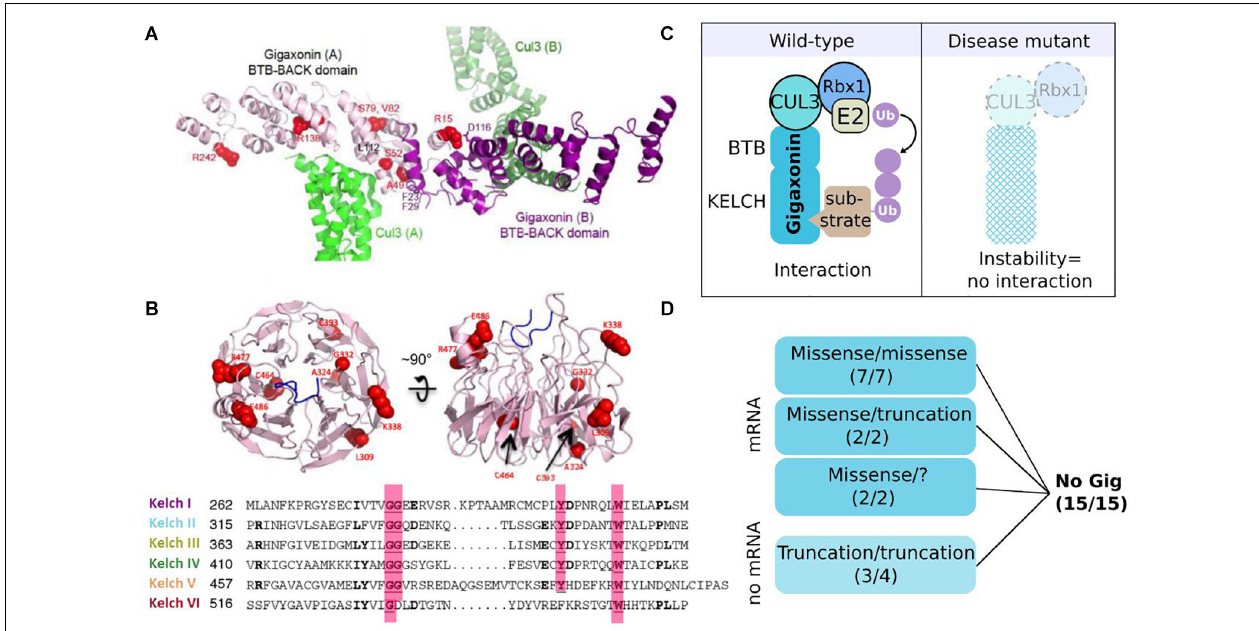
FIGURE 5 | Gigaxonin-E3 ligase: protein structure and instability as a general effect of mutations. (A) Structural model of the BTB-BACK homodimer of Gigaxonin (purple), in complex with Cul3 (green). Some mutations are represented in red (Boizot et al., 2014). (B) Representation of the top and side views of a structural model for the β -propeller Kelch domain of Gigaxonin, whose 6-blades are shown in sequence alignment below. Some mutations are represented in red. (C) In wild-type condition (left) Gigaxonin interacts with Cul3 through its N-terminal BTB domain and binds to substrates through its C-terminal Kelch domain, hence catalyzing the transfer of ubiquitin chain from the E2 to the recognized substrate. In disease (right), GAN mutations induce a general instability of Gigaxonin, by affecting the proper folding of the BTB or Kelch domain, or impairing homodimerization and interaction with Cul3. (D) Dramatic reduction of Gigaxonin levels in patient’s cells: due to instability of the mutated protein, or degradation of the corresponding mRNA, depending on the mutation type and combination. “?”: compound heterozygous mutations await to be discovered. Copyright with permission from BioMed